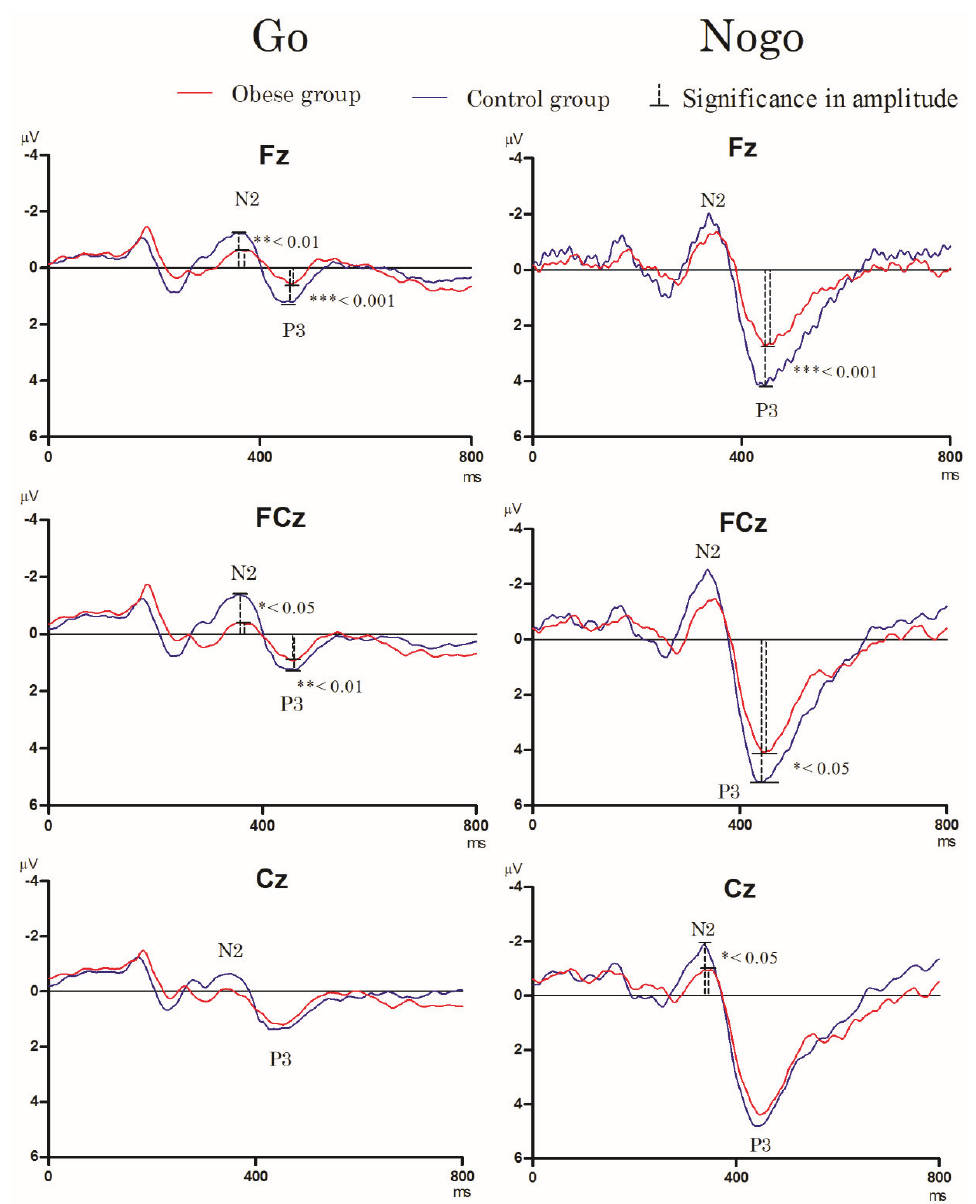
Figure 1. Grand averaged ERPs of N2 and P3 waveforms in the Go and Nogo conditions in three electrodes (Fz, FCz, and Cz) for the normal-weight control group (CG) and the obese group (OG) in the Go/Nogo task.